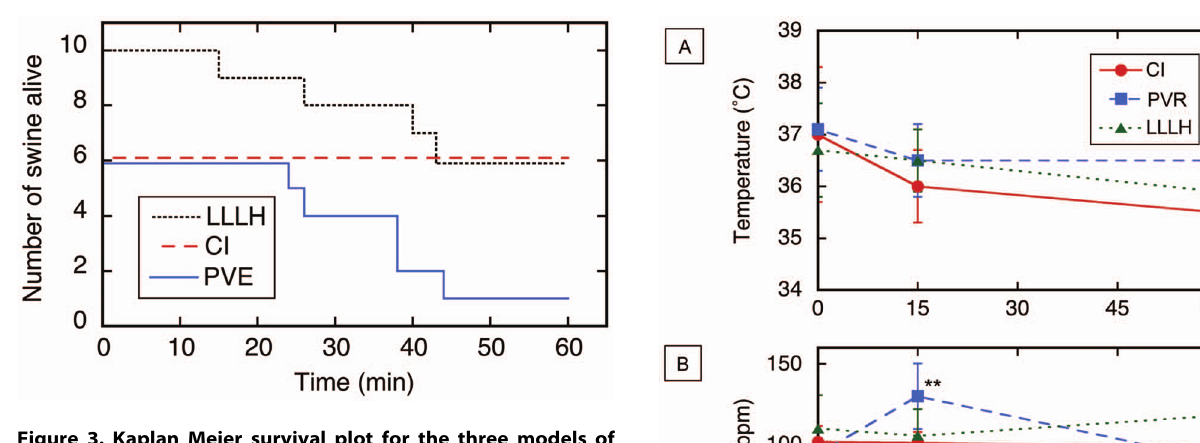
Figure 3. Kaplan Meier survival plot for the three models of noncompressible hemorrhage. Time zero=moment of injury; CLI=central liver injury (N=6); PVR=portal vein resection (N=6); LLLH=hepatic left lower lobe hemitransection (N=10).